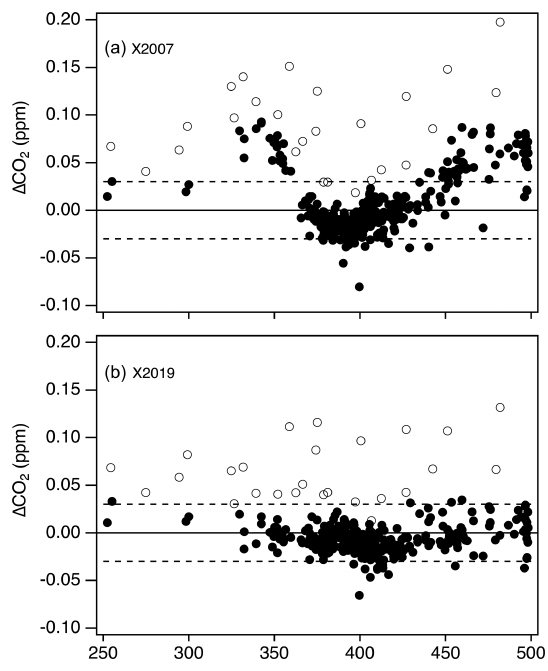
Figure 12. Differences between NDIR and laser spectroscopic sys- tems used for tertiary value assignment on X2007 (a) and X2019 (a) during a 12-month overlap period. Open symbols denote tertiary standards with significantly lower 13 C-CO 2 isotopic ratios com- pared to the others ( δ 13 C < − 20‰), which are thus subject to bias in the NDIR measurement. Dashed lines are the expected repro- ducibility of the NDIR system ( ± 0.03ppm).